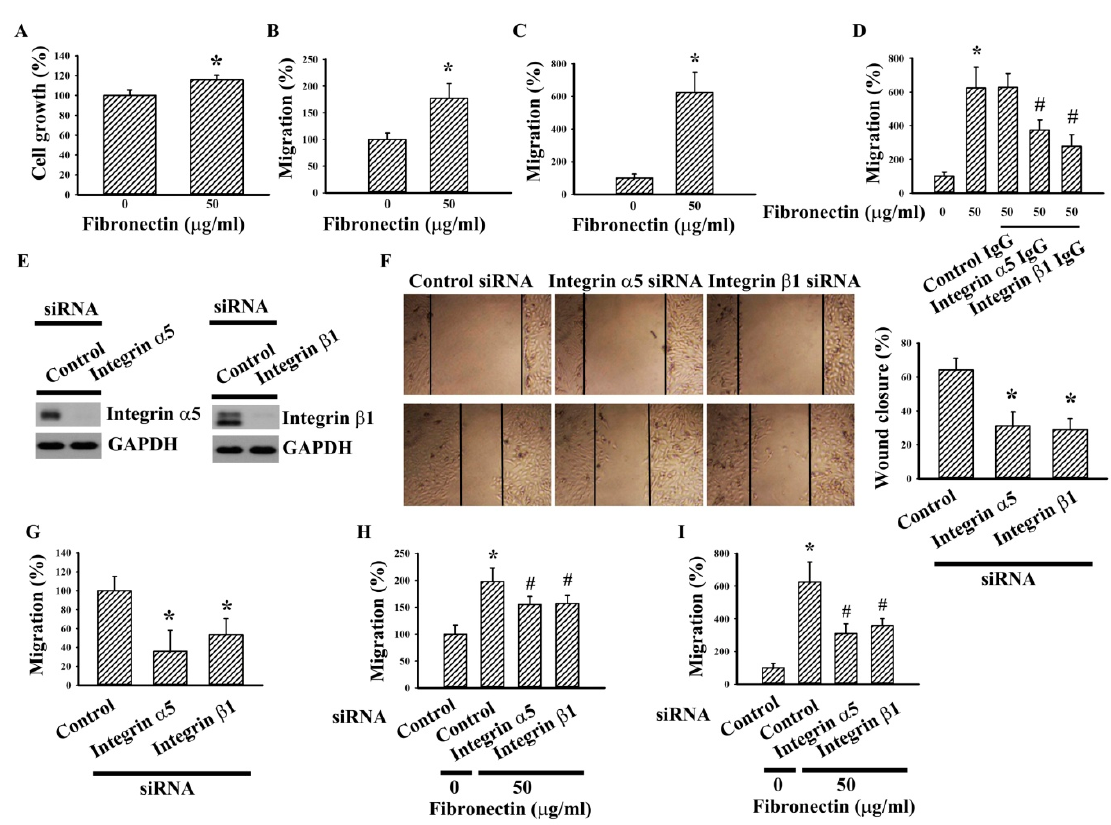
Figure 2. Integrin α 5 and integrin β 1 silencing alleviated fibronectin effects in 786-O cells. ( A ) 786-O cells were seeded onto fibronectin (0 and 50 µ g / mL)-coated 96-well plates. Twenty-four hours later, cell growth was measured by MTS reduction assay. ( B ) 786-O cells were seeded onto fibronectin (0 and 50 µ g / mL)-coated Transwell inserts and subjected to Transwell migration assay for 24 h. The lower chambers were filled with DMEM containing 10% FBS. ( C ) 786-O cells were seeded onto